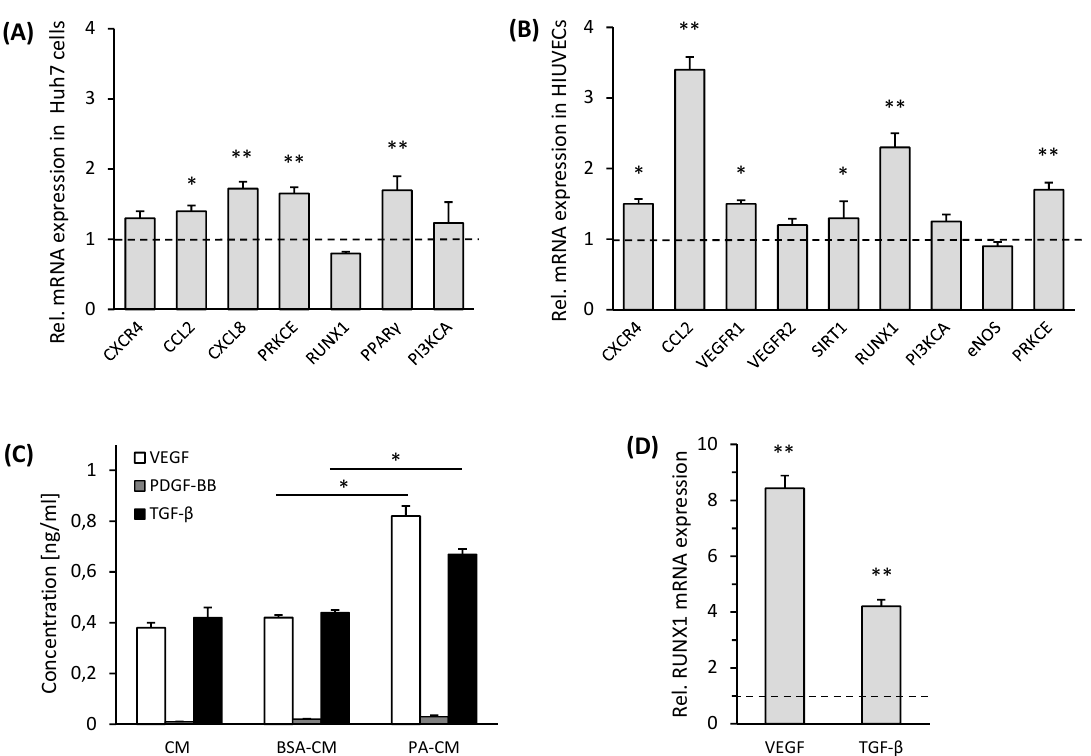
Figure 3. RUNX1 and angiogenic gene expression in endothelial cells maintained in conditioned medium (CM) from palmitic acid (PA) treated hepatoma (Huh7) cells. ( A ) Huh7 cells treated with 0.2 mM PA for 48 h were analyzed for mRNA expression of RUNX1 and genes identified as angiogenesis associated DEGs in human NASH samples. The dotted line represents the control showing gene expression in Huh7 cells treated with BSA ( n = 4). ( B ) HUVECs incubated with CM from PA-Huh7 cells were analyzed for mRNA expression of RUNX1 , its target and angiogenic genes. The dotted line represents control, showing gene expression in HUVECs treated with CM from BSA-Huh7 cells ( n = 4). 18S RNA expression was used for normalization. ( C ) Huh7 cells were treated with BSA or PA or CM alone and analyzed for the release of VEGF, PDGF-BB and TGF- β (pg / mL) ( n = 3). ( D ) Relative RUNX1 mRNA expression in HUVECs treated with VEGF and TGF- β (10 ng / mL each) for 24 h. Un-induced cells without any manipulation were used as respective controls (Dotted line) ( n = 3). 18S RNA expression was used for normalization. Data represent mean ± SD. * p < 0.05; ** p < 0.001. Moreover, HUVECs maintained for 24 h in culture medium (CM) from Huh7 cells treated